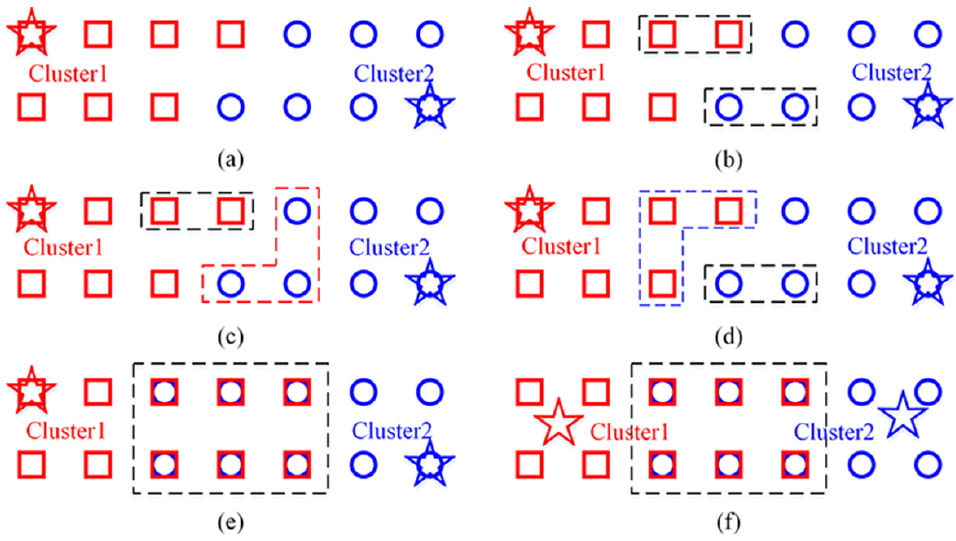
Figure 3. The illustration of adjusting